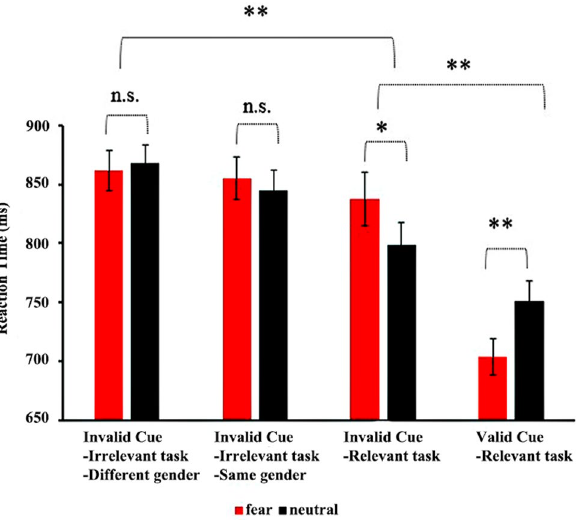
Figure 1. Reaction time for different top-down goals with fearful and neutral faces; * P < 0.05, ** P <